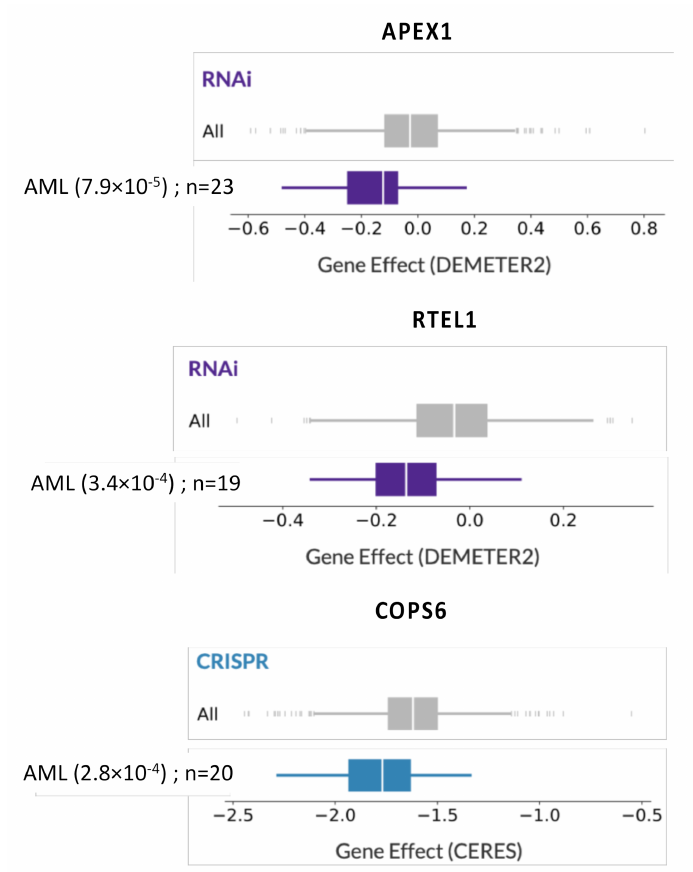
Figure 1. The silencing of APEX1 , RTEL1, and COPS6 impairs acute myeloid leukemia (AML) cell growth. Using CRISPR or RNAi screening publicly available data (Dependency Map data, Broad Institute, www.depmap.org), dependency scores of APEX1 , RTEL1, and COPS6 underline their specific importance for AML cell survival compared to all cell lines